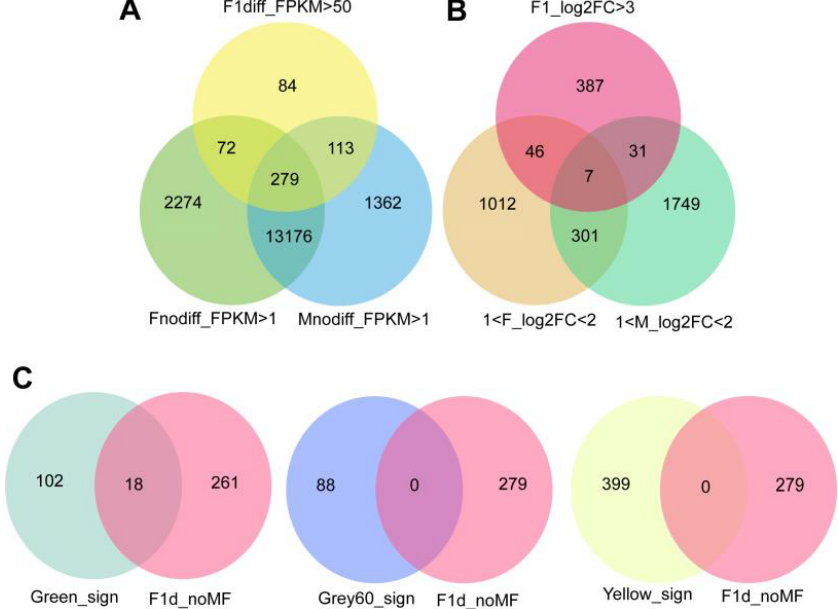
Figure 2. Screening candidate genes for heterosis. ( A ) Genes were expressed in the parents, but more were expressed in the hybrid. ( B ) DEGs in the parents, with increased differential fold in the hybrid. ( C ) Genes associated with both drought stress and heterosis.